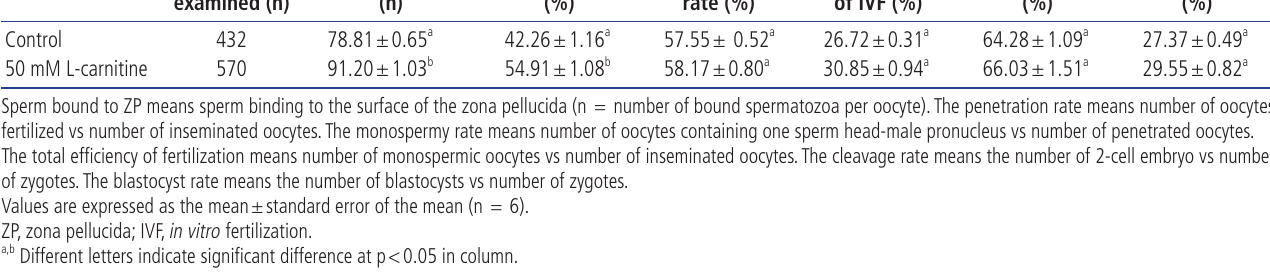
Table 5. Effects of L-carnitine on boar sperm fertility and developmental potential Oocytes Sperm bound to ZP Treatment examined (n) (n)